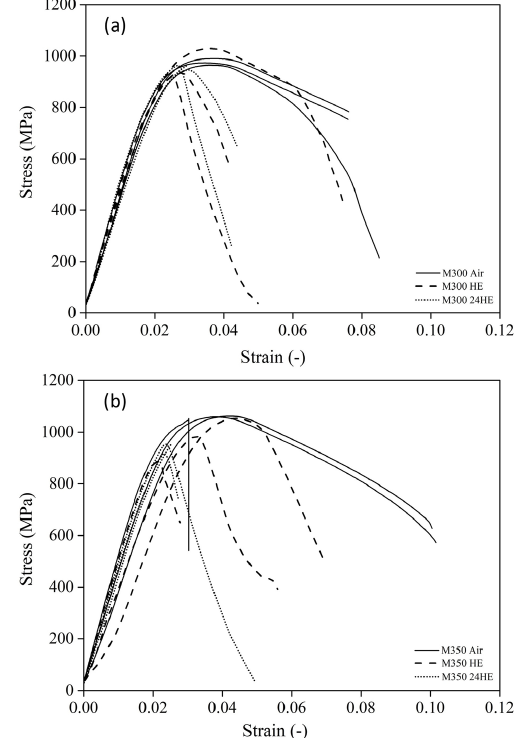
Figure 2. SSRT stress-strain curves of solution treatment specimens of maraging (a) M300 and (b) M350 in air and under HE conditions.